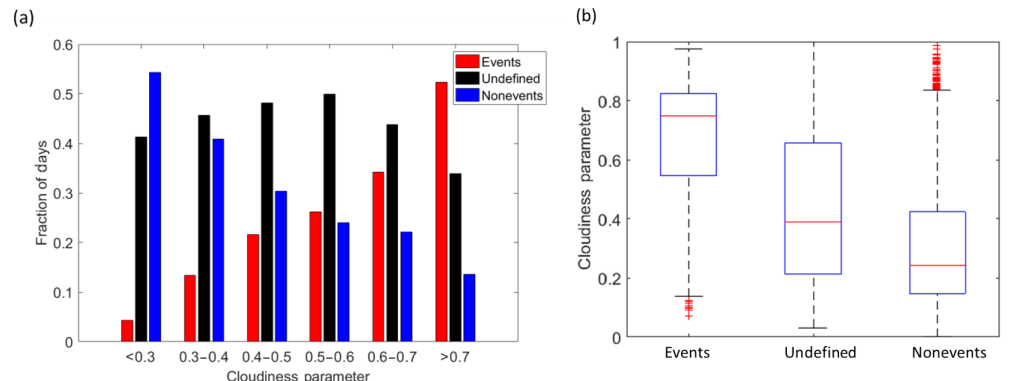
Figure 1. (a) Figure showing the fraction of days which are classified as NPF events, nonevents and undefined days during different sky cloudiness conditions. (b) Daily (09:00–12:00) medians and percentiles of cloudiness recorded during NPF event, undefined and nonevent days. The red line represents the median of the data and the lower and upper edges of the box represent 25th and 75th percentiles of the data, respectively. The length of the whiskers represent 1.5 × interquartile range which includes 99.3% of the data. Data outside the whiskers are considered outliers and are marked with red